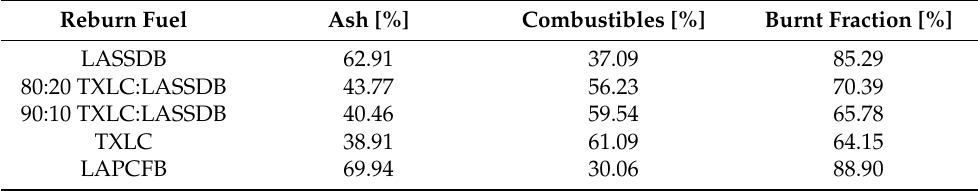
Table 7. Burnt fraction (BF) on a dry basis for the bottom ash of reburn